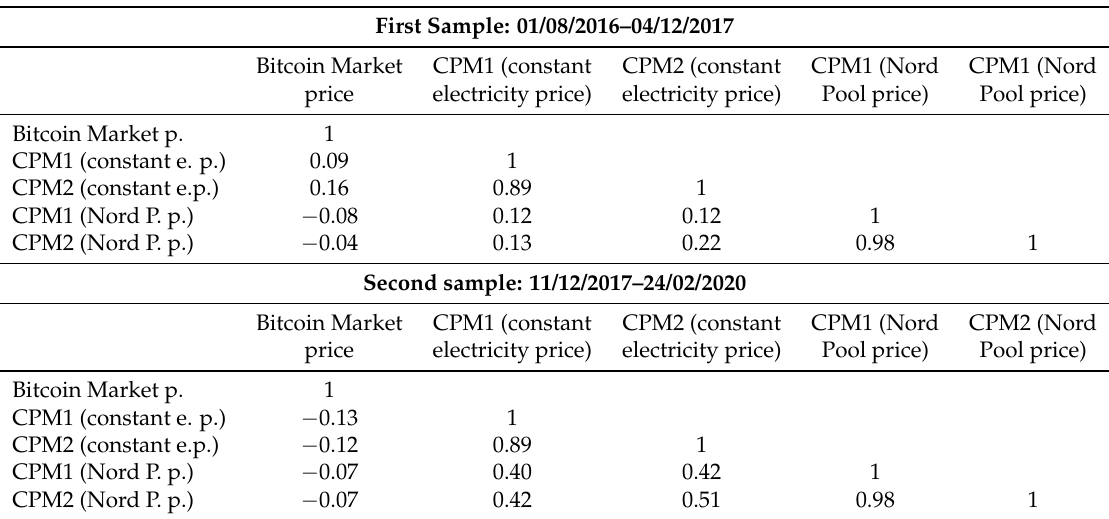
Table A14. Correlation matrices of the log-returns for the bitcoin price, the baseline CPMs with constant electricity, and the CPMs computed with the Nord pool prices.